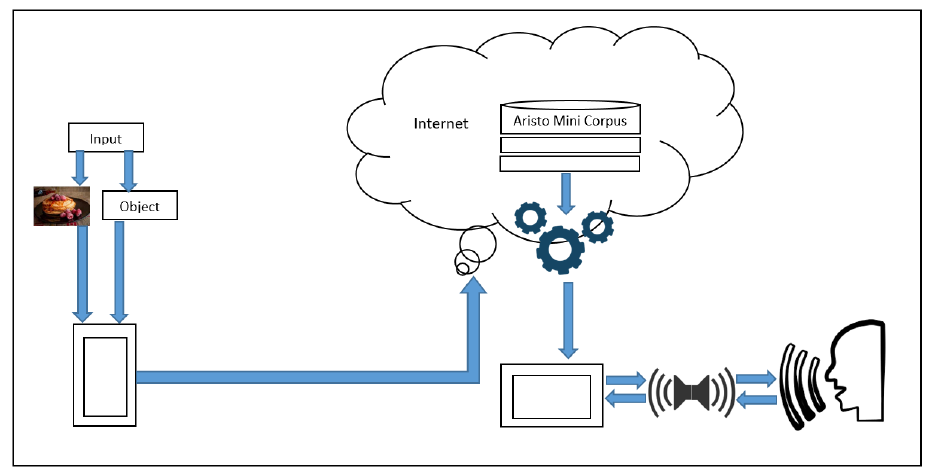
Figure 1. Proposal Framework for the process of all